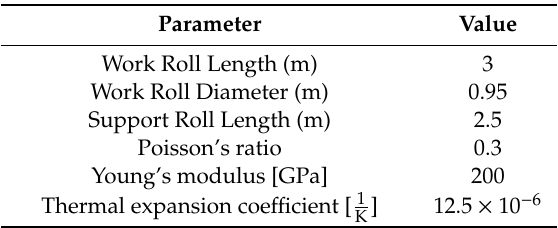
Table 2. Work roll geometry and physical